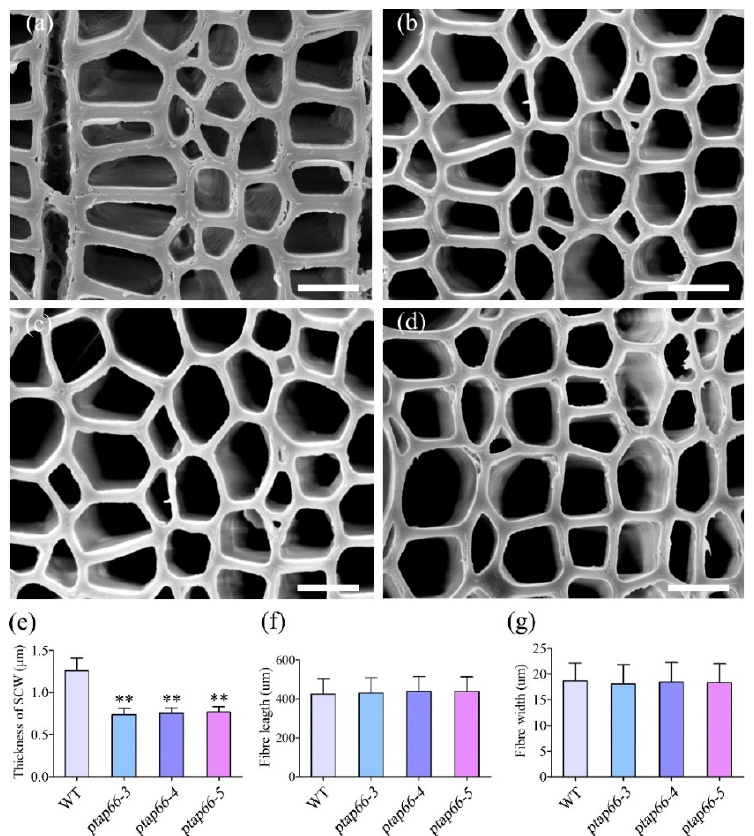
Figure 5. Effects of CRISPR-edited mutations in PtAP66 on wood fibre anatomy. SEM images of representative mature wood fibre walls of IN12 in WT ( a ), ptap66-3 ( b ), ptap66-4 ( c ), and ptap66-5 plants ( d ) at 4 months of age. Bar = 10 μ m. ( e ) Statistical analysis of the SCW thickness of mature fibres in the xylem of ptap66 mutants and WT plants. Statistical analysis of xylem fibre length ( f ) and fibre width ( g ) in the xylem of ptap66 mutants and WT plants. Error bars represent ± SD values of three biological repeats. Asterisks indicate significant differences between each line of ptap66 mutants and WT plants by Student’s t -test (** p < 0.01).